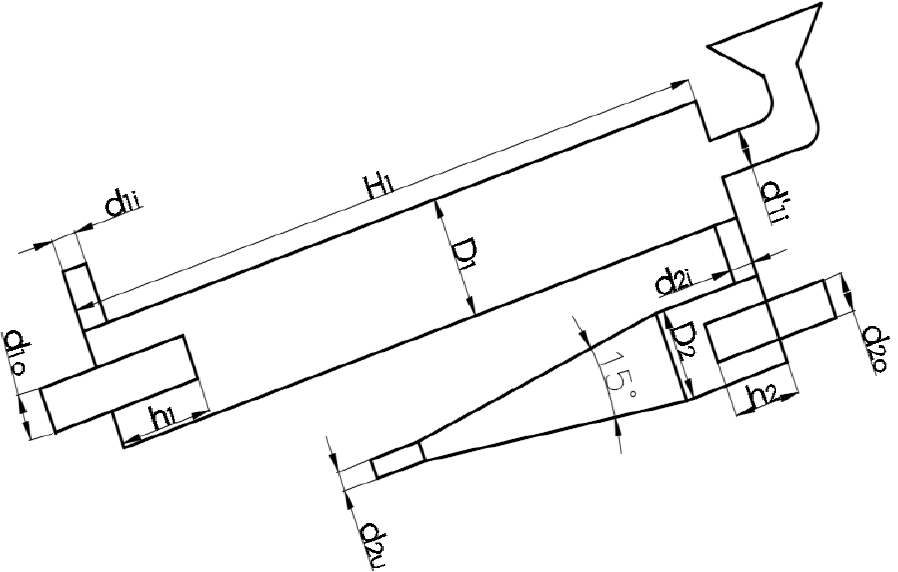
Figure 1. Illustration of the structure of the hydrocyclone sand washer.